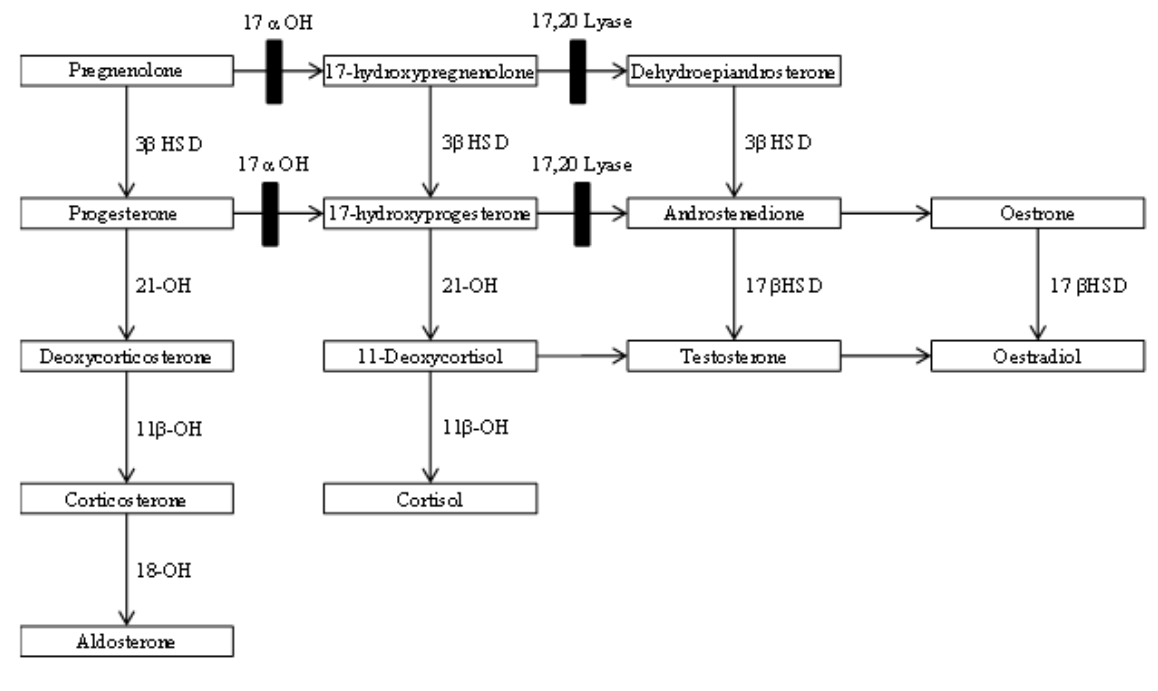
Figure 1. Adrenal steroid synthesis. Deficiency in 17 á hydroxylase/17,20-lyase results in accumulation of deoxycorticosterone (DOC) and consequent hypertension; reduced cortisol and androgen